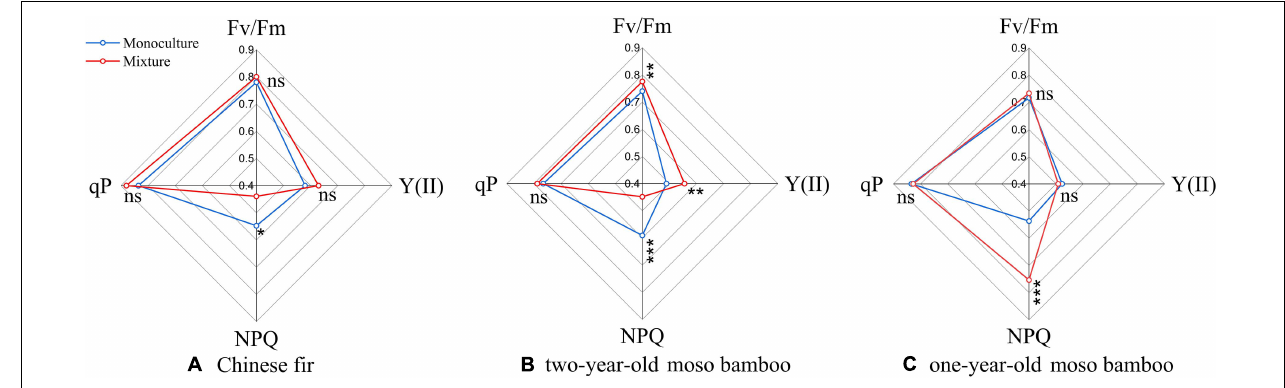
FIGURE 3 | Radar plot showing various fluorescence parameters of the different stand types. (A) Chinese fir. (B) 2-year-old moso bamboo. (C) 1-year-old moso bamboo. Each line represents the average of 27 measurements per stand type. * P < 0.05, ** P < 0.01, and *** P < 0.001.